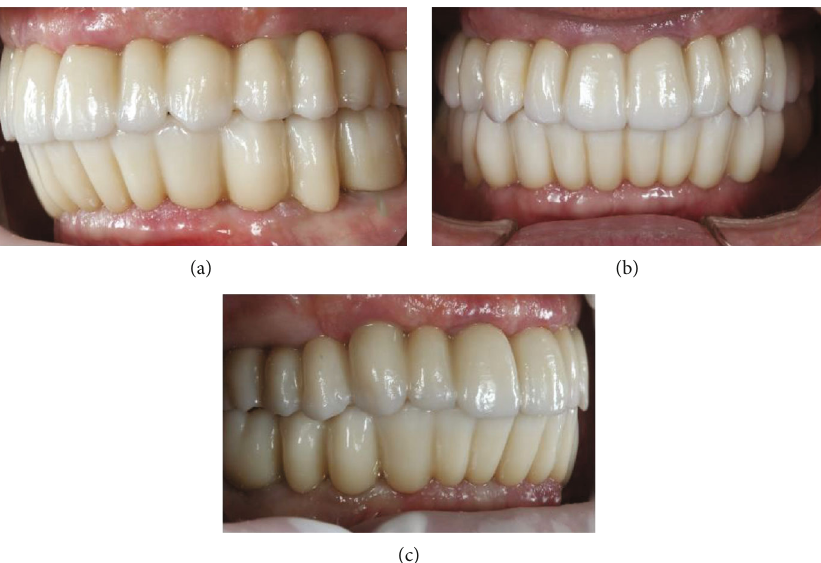
Figure 10: Occluding prostheses: left side (a), front side (b), and right side (c).